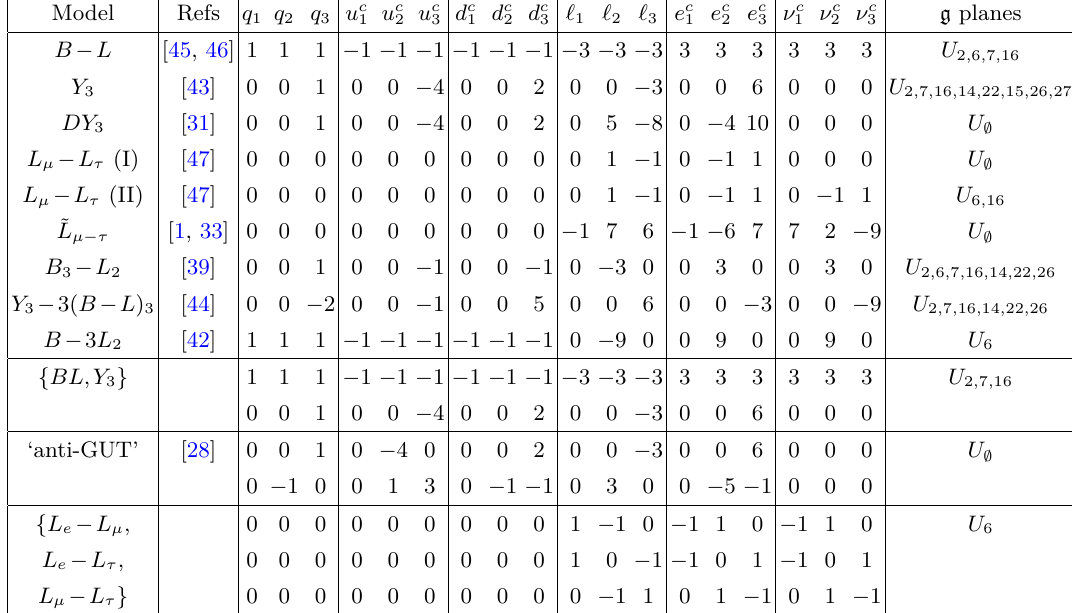
Table 4 . Selection of anomaly-free U (1)(1) X extensions of the SM, and the planes in which they embed. The notation in the far column U indicates that the given charge assignment embeds i 1 ,...i n in the planes P , P , . . . P but not in any others in the list (4.2)–(4.11). Embedding in a plane i 1 i 2 i n P i means that the sm ⊕ u (1) X extension embeds in a semi-simple gauge theory with gauge algebra g i , corresponding to the numbered list in table 1 (as well as other algebras for which the planes are equivalent, as explained in the main text). In addition to the particular solution labelled ˜ L